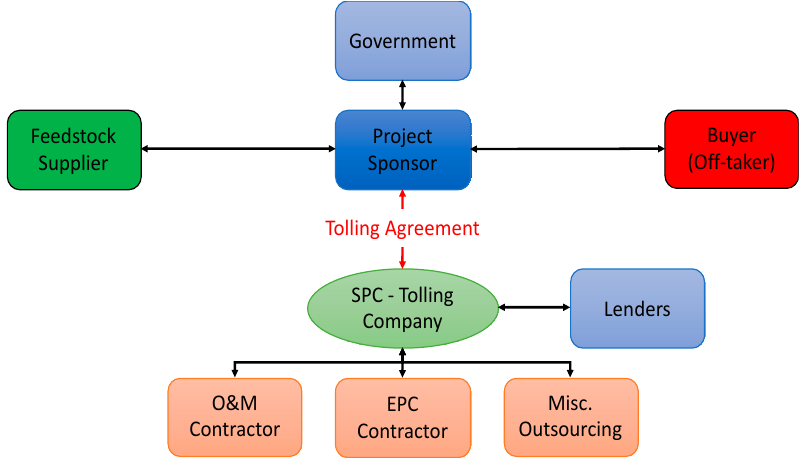
Figure 2. Tolling model (modified from [4]).